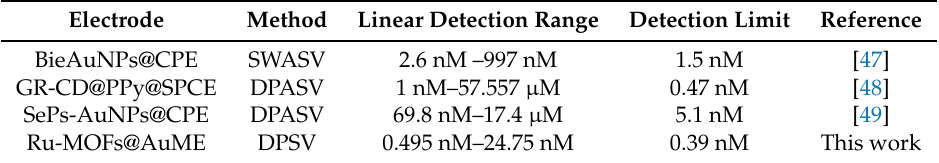
Table 2. Comparison of analytical performances with other anodic stripping methods for the determination of trace mercury in aqueous